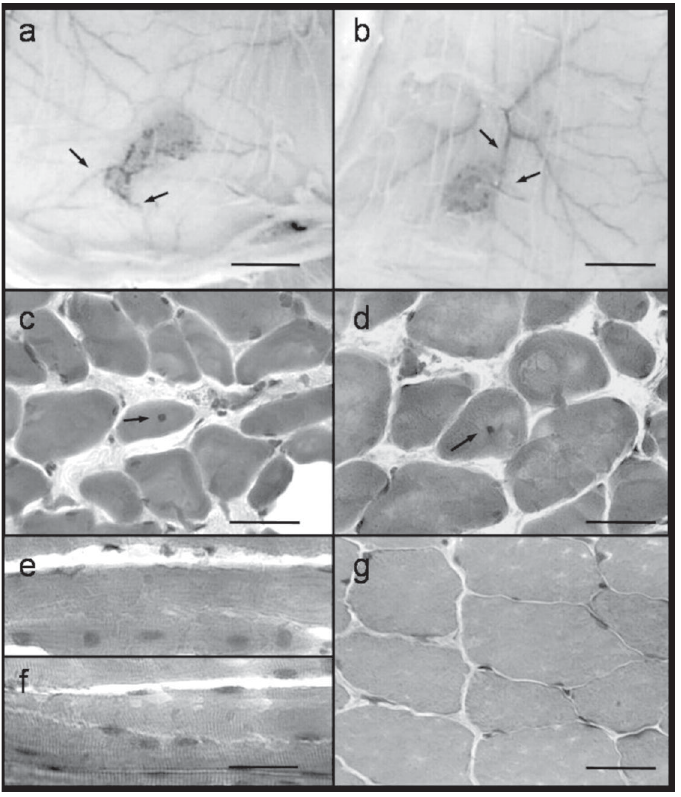
Figure 2. Inactive X chromosome of the skeletal muscle cells. In order to identify the origin of ectopically devel- oped muscle fibers, sections obtained 7 days after transplantation of female satellite cells were stained with cresyl violet and compared to extensor digitorum longus muscle (EDL) sections from adult female and male rats. Nuclei containing an inactive X chromosome (indicated by the arrows) were observed in both allo- grafts (a,b) and female EDL (c,d), but not in male EDL